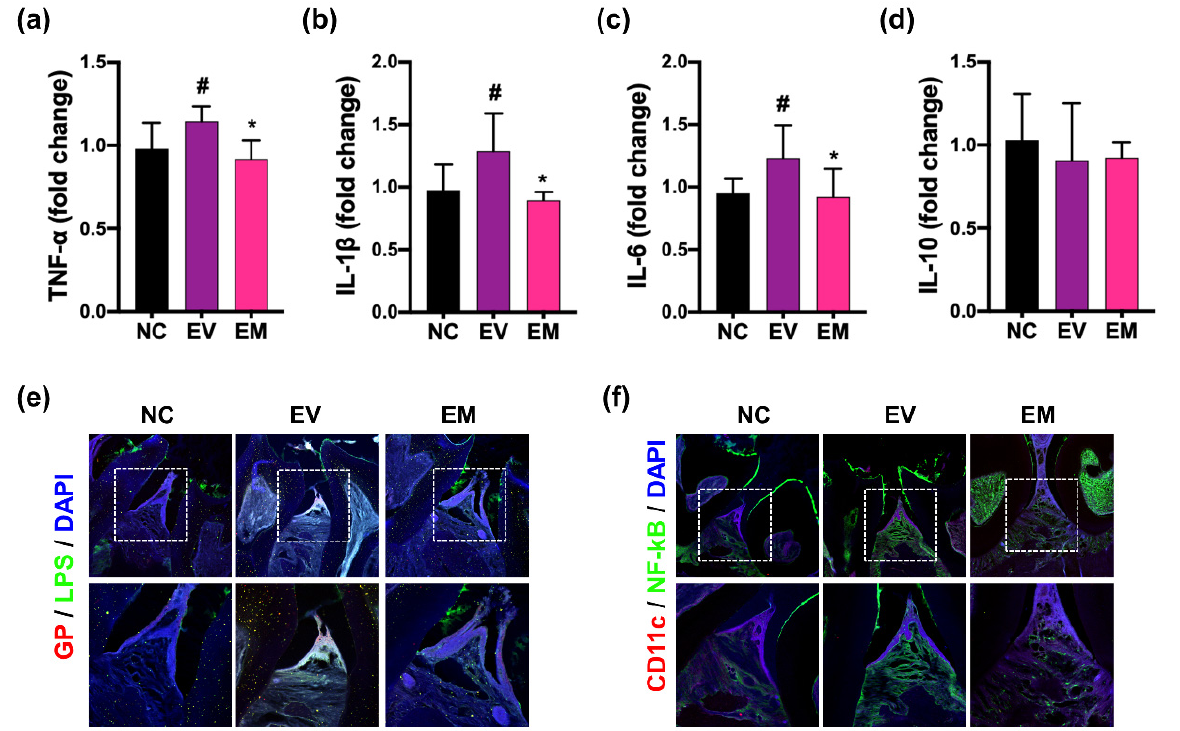
Figure 5. NKc alleviated pEVs-induced periodontitis in mice. Effect on TNF- α ( a ), IL-1 β ( b ), IL-6 ( c ), and IL-10 expression ( d ) in the periodontal tissue. Effect on GP + LPS + ( e ) and NF- κ B + CD11c + cell populations ( f ) in the periodontal tissue. Data were indicated as mean ± SD ( n = 6). # p < 0.05 vs. NC. * p < 0.05 vs. EV.